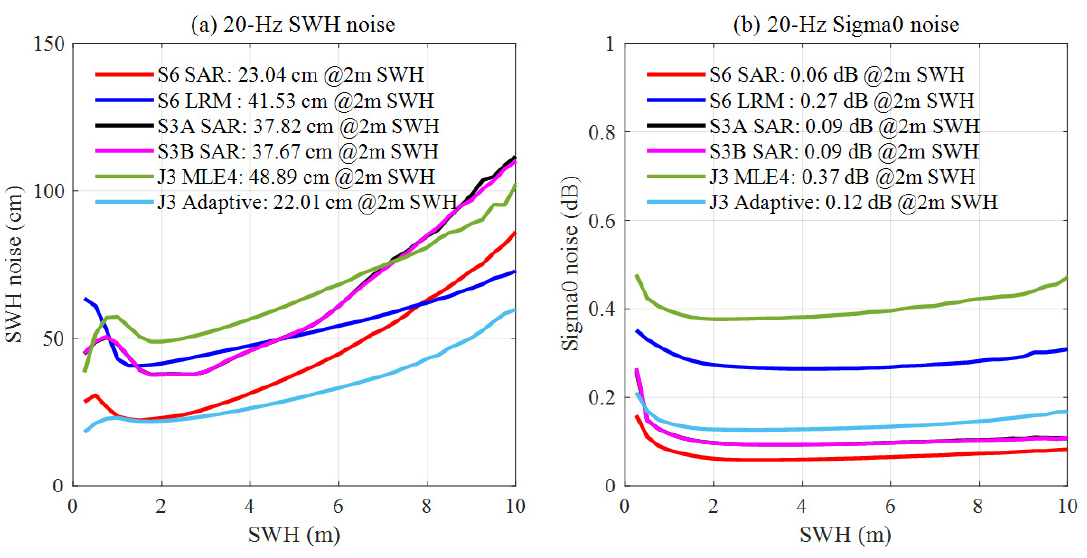
Figure 8. Sentinel-6 20 Hz ( a ) SWH noise and ( b ) sigma0 noise and their comparisons with Sentinel- 3A/B and Jason-3